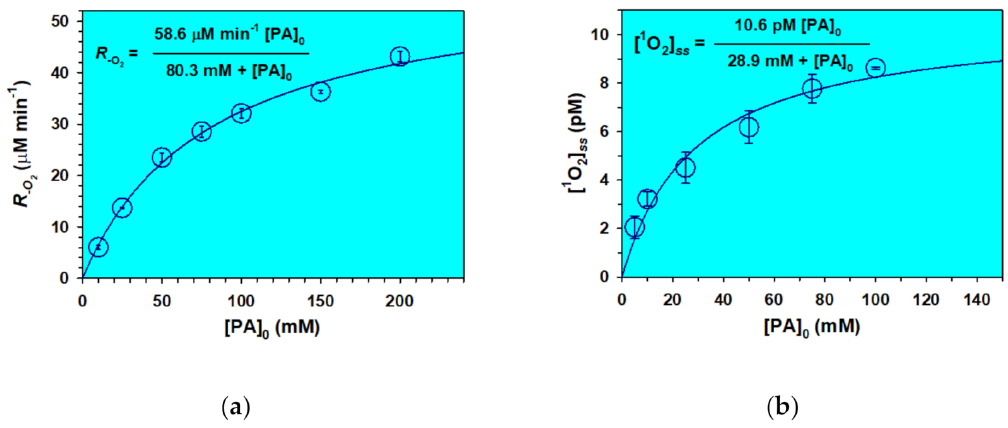
Figure 7. ( a ) Rate of dissolved oxygen decay ( R O ) at variable initial concentration of PA during λ ≥ 305 nm irradiation of 2 ( aq ) solutions initially saturated with air. The complete experimental conditions can be found in the original work [86]. Adapted from data published in Eugene and Guzman; The Effects of Reactant Concentration and Air Flow Rate in the Consumption of Dissolved O2 during the Photochemistry of Aqueous Pyruvic Acid. Molecules. 2019, 24 (6), 1124; ( b ) steady-state singlet oxygen production ([ 1 O 2 ] ss ) during 1 h irradiation at λ ≥ 305 nm of under continuous and stable saturation with the air of PA solutions. Other experimental conditions can be found in the original work [87]. Copyright 2019, American Chemical